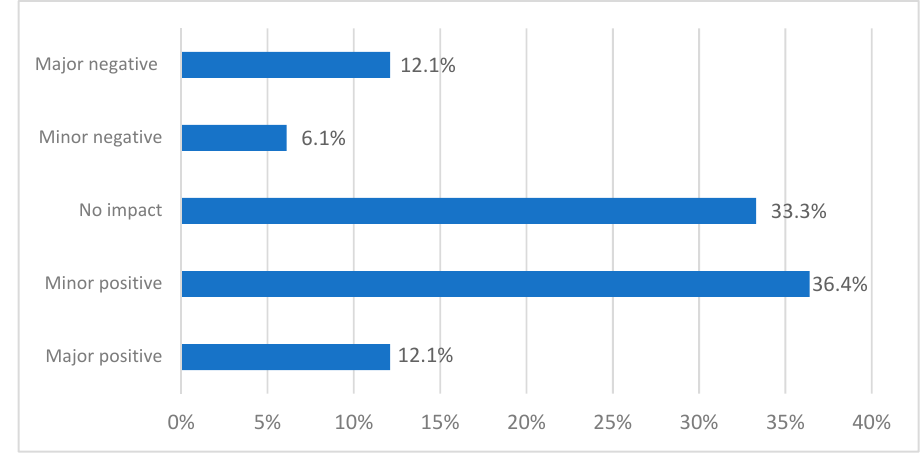
Figure 3. Impact of concerns on the actual study. Total is >100% because multiple answers were allowed.